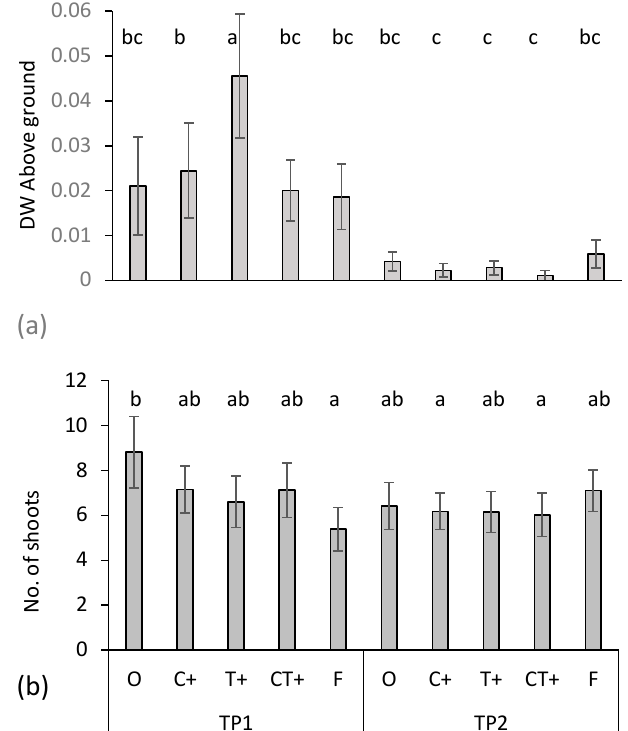
Figure 3. Effect of the mother plant growth under climate change conditions (see text) and test period (TP1, TP2) for ( a ) dry weight of the above-ground parts of C. arvense and ( b ) number of shoots of E. repens . The bars indicate ± SE. Different letters (a,b,c) indicate significant differences.